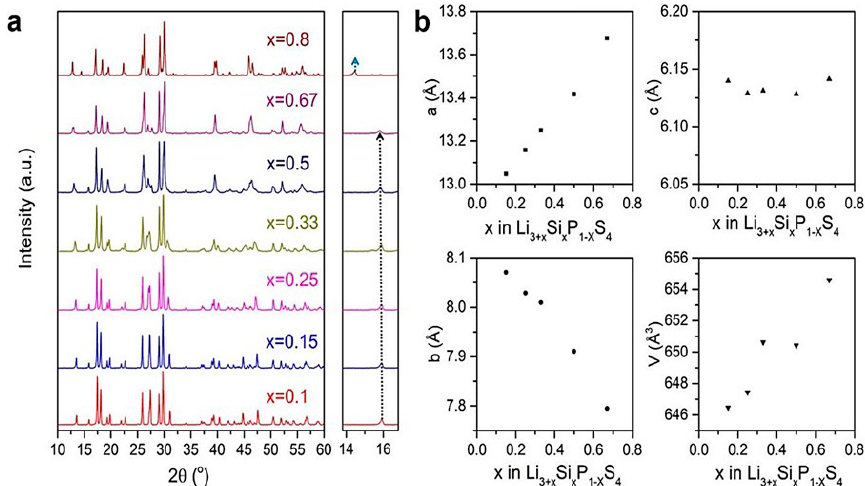
Figure 12. ( a ) Selected X-ray diffraction patterns of as-synthesized Li 3+ x [Si x P 1 − x ]S 4 ( x = 0.1, 0.15, 0.25, 0.33, 0.5 0.67, 0.8); the black arrow indicates the (101) reflection for orthorhombic Li 3 + x [Si x P 1 − x ]S 4 ( x = 0.1, 0.15, 0.25, 0.33, 0.5, 0.67) and the blue arrow indicates the (100) reflection for monoclinic Li 3.8 [Si 0.8 P 0.2 ]S 4 . ( b ) Changes in lattice parameters and unit cell volume of orthorhombic Li 3+ x [Si x P 1– x ]S 4 phases with the Si content for single crystal structure solutions at 280 K. Reproduced with permission from [222]. Copyright 2019 American Chemical Society.